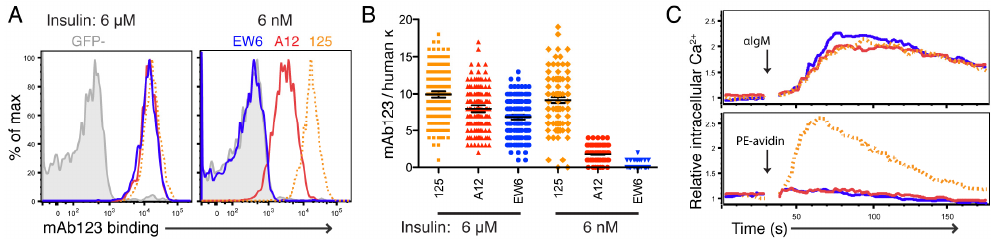
Figure 2. 125 BCR has high avidity for insulin. ( A ) Receptor occupancy measured by mAb123 binding to TR-B cells (gated on B220+, GFP+, IgM+) incubated with 6 µ M (left) or 6 nM insulin